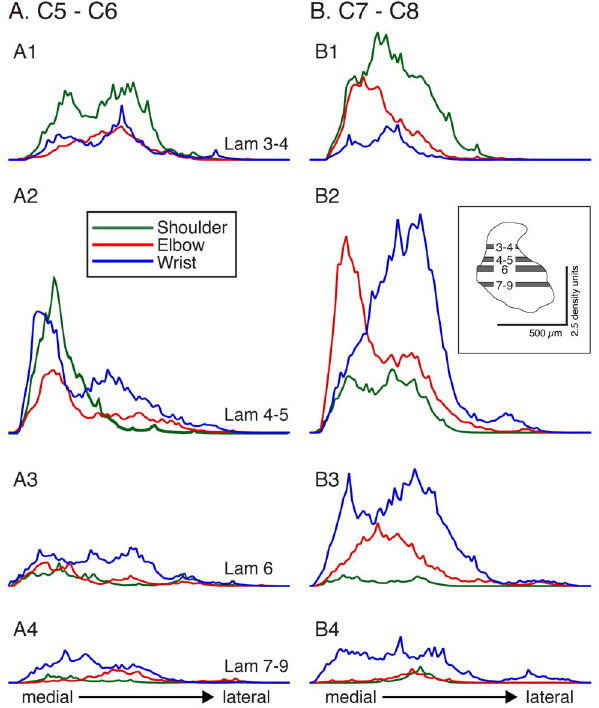
Figure 5. Dorsoventral changes in CST labeling. A. C5/C6. B. C7/ C8. Left column plots mean 6 SE of average label within each ROI (see inset), for each motor cortex joint zone. Bars plot values for laminae 3–4, laminae 4–5, lamina 6, and laminae 7–9. Horizontal lines at the bottom of each set of bar graphs indicate significant differences on post-hoc analysis (Scheffe test). Stacked percentage bar graphs in right column plot CST contributions from each motor cortex joint zone to the different dorsoventral laminar regions